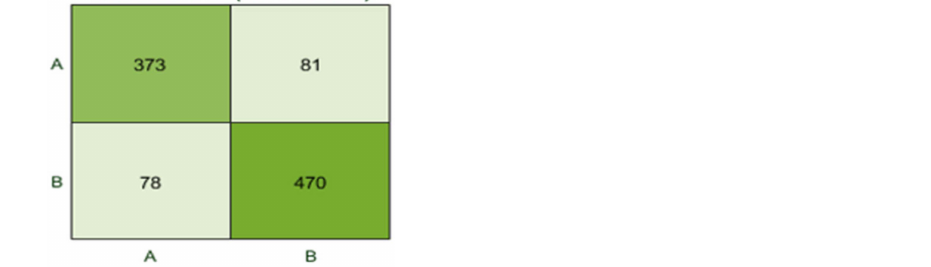
Figure 16. Confusion matrix for Q(SVM) with 500 features and using 500 fatures with 5-fold results.